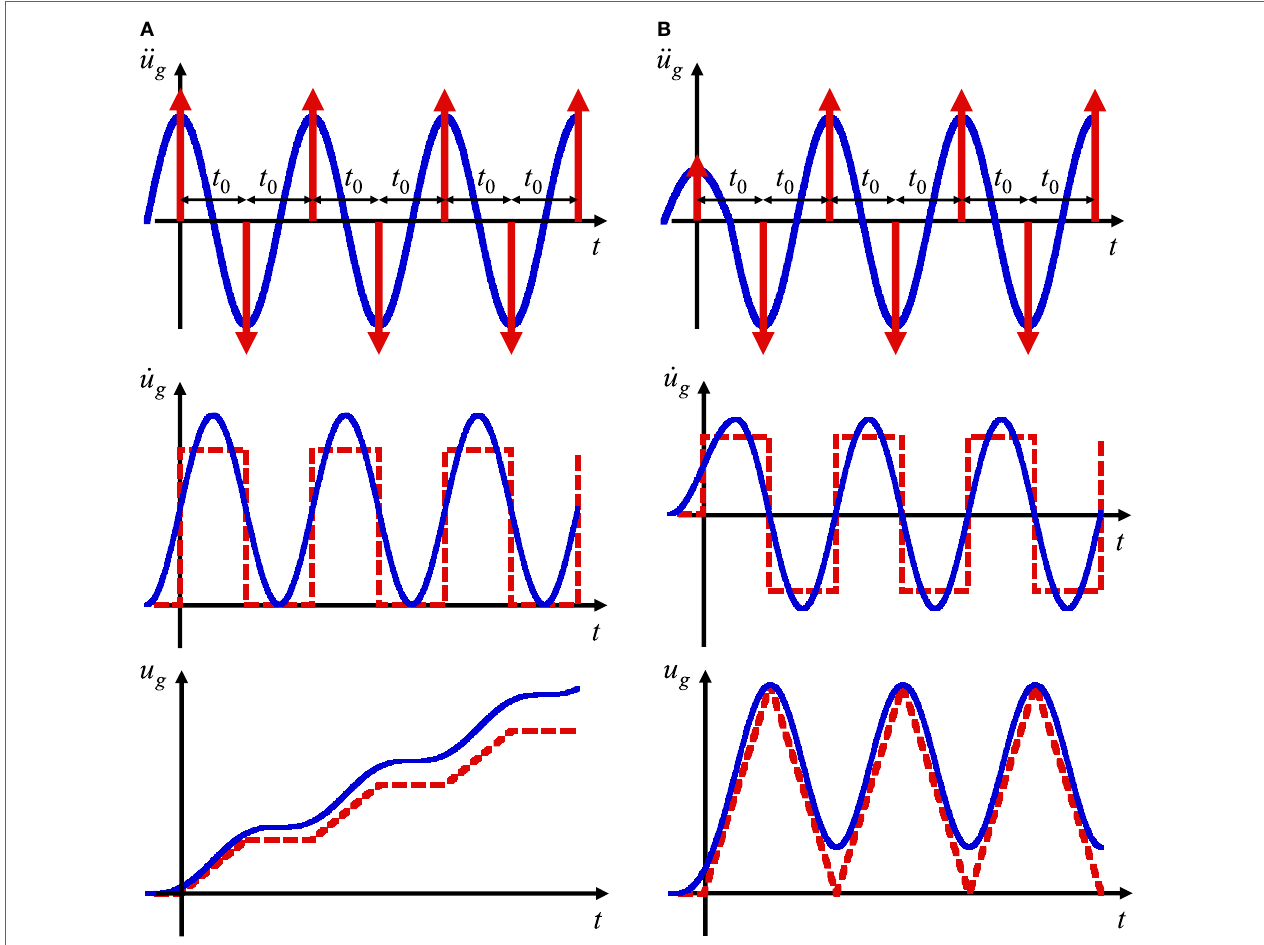
FigUre 2 | long-duration earthquake ground motion in terms of sinusoidal waves and the corresponding multiple impulse: (a) multiple impulse with equal magnitude and (B) multiple impulse with smaller magnitude of first impulse